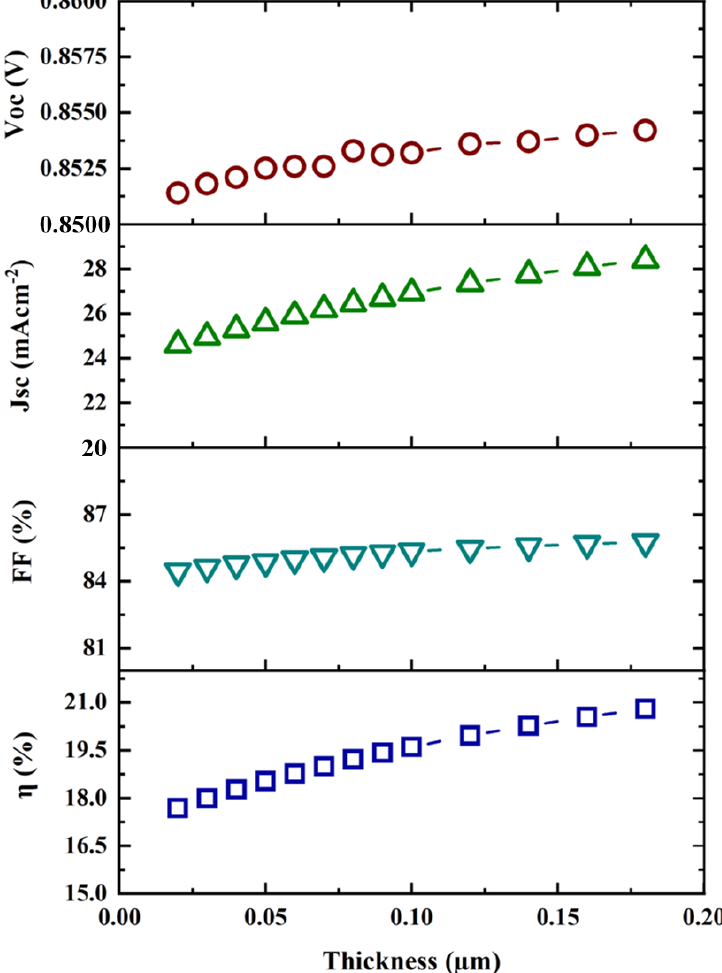
Figure 2. Buffer layer thickness versus V oc , J sc , FF, and η.